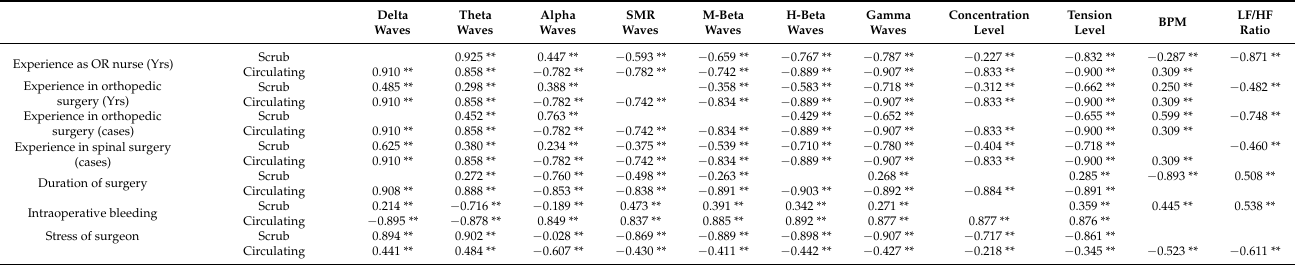
Table 2. Correlation of stress-related parameters between scrub and circulating nurses. ** p < 0.01, Pearson correlation